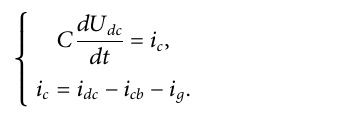
Frontiers in Energy Research |